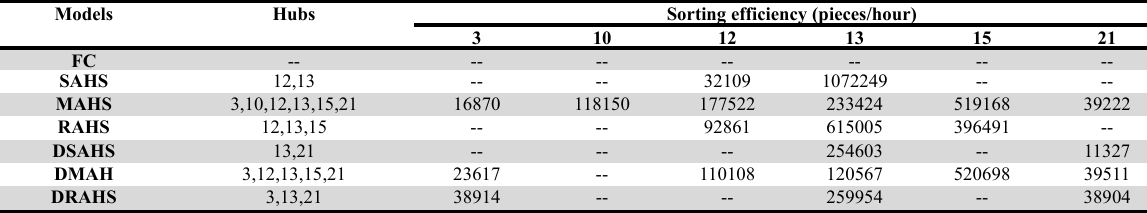
The selected hubs and its sorting efficiency for the optimal solution Models